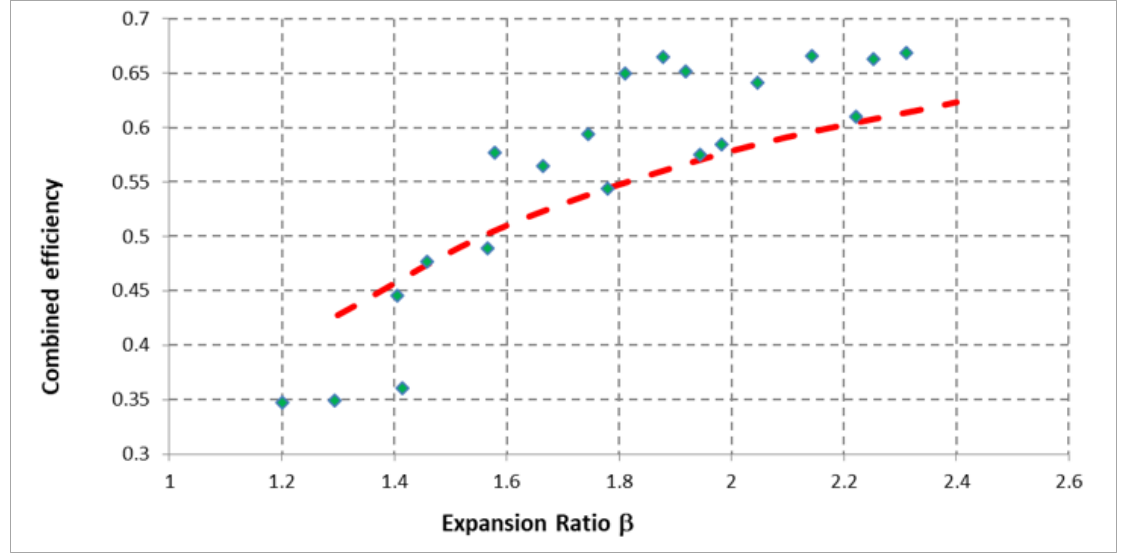
Figure 4. Combined efficiency T m as a function of expansion ratio β . Green rhombi are the value T m obtained with Equations (10), (12) and (22), whereas the red line shows the experimental results obtained in [38].